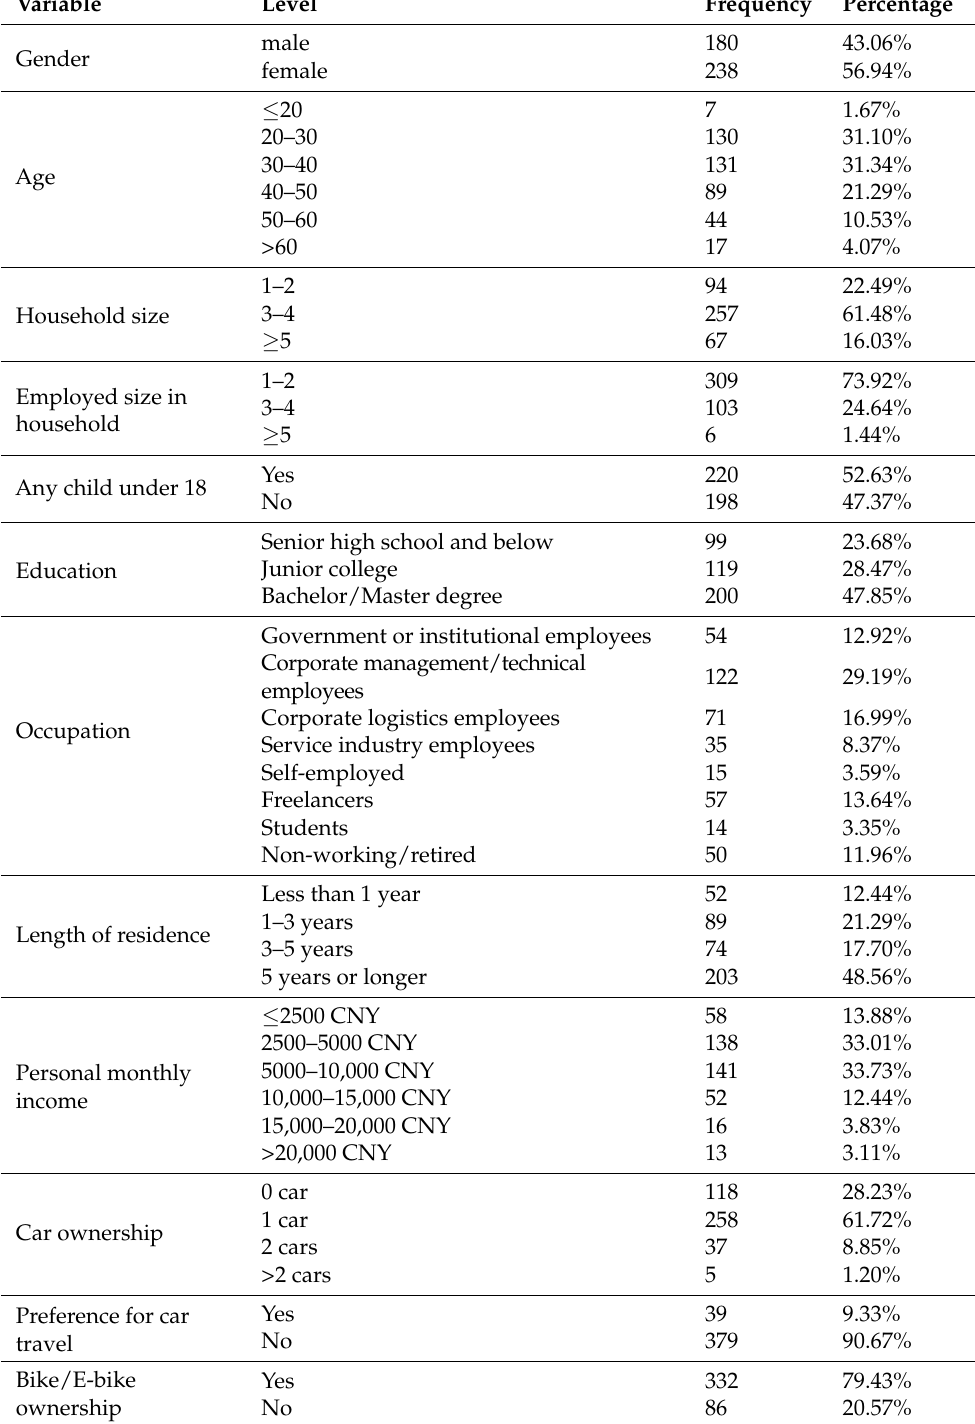
Table 2. Distribution of socioeconomic attributes for